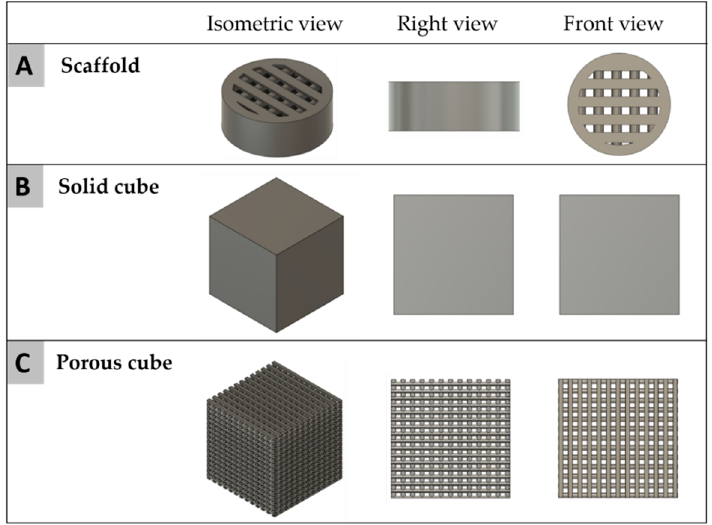
Figure 14. CAD design models of ( A ) in vivo scaffold, ( B ) solid cube, and ( C ) porous cube.